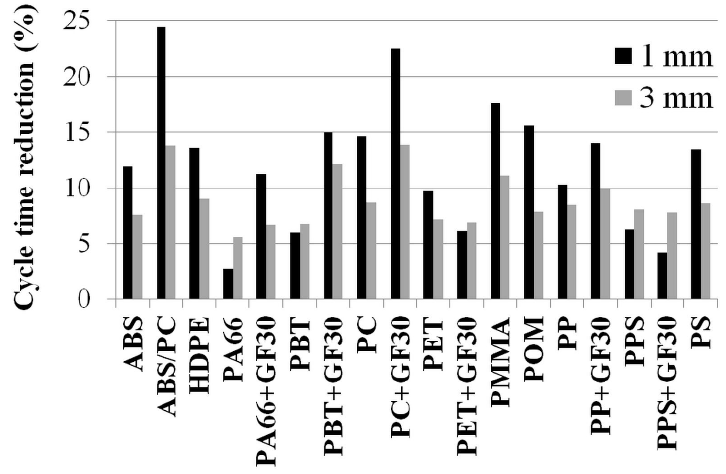
Figure 6. Cycle time reduction of test alloy compared to 1.2343 ESU for different polymers and two wall thicknesses.